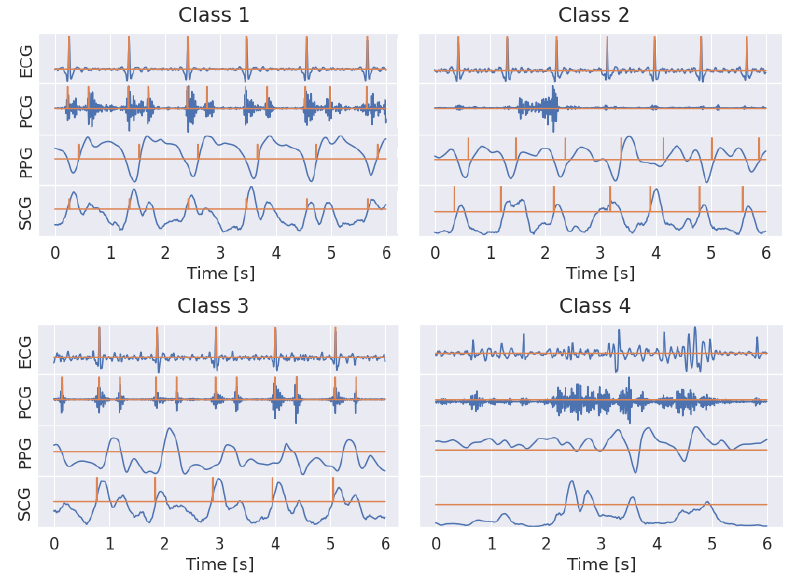
Figure 3. Examples of labeled signals in the four different classes. ECG, PCG, PPG and SCG are represented in row from top to bottom. The label is represented by a binary signal, featuring 1 in correspondence of the detected characteristic point. In class 1, the typical SCG pattern, featuring two peaks corresponding to cardiac sounds, can be